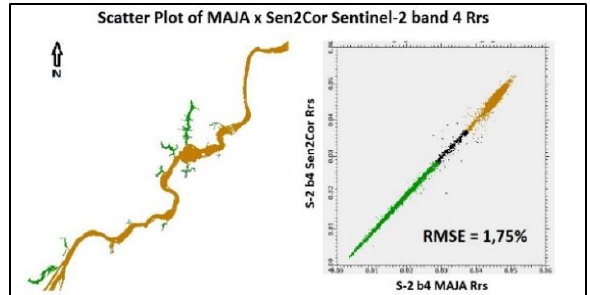
Figure 2. Reflectance by reservoir region 3.2 Comparison between Sentinel-2 mean reflectance estimated by GRS, MAJA and Sen2Cor corrections and mean reflectance measured by MODIS. The reflectances of the Sentinel-2 products